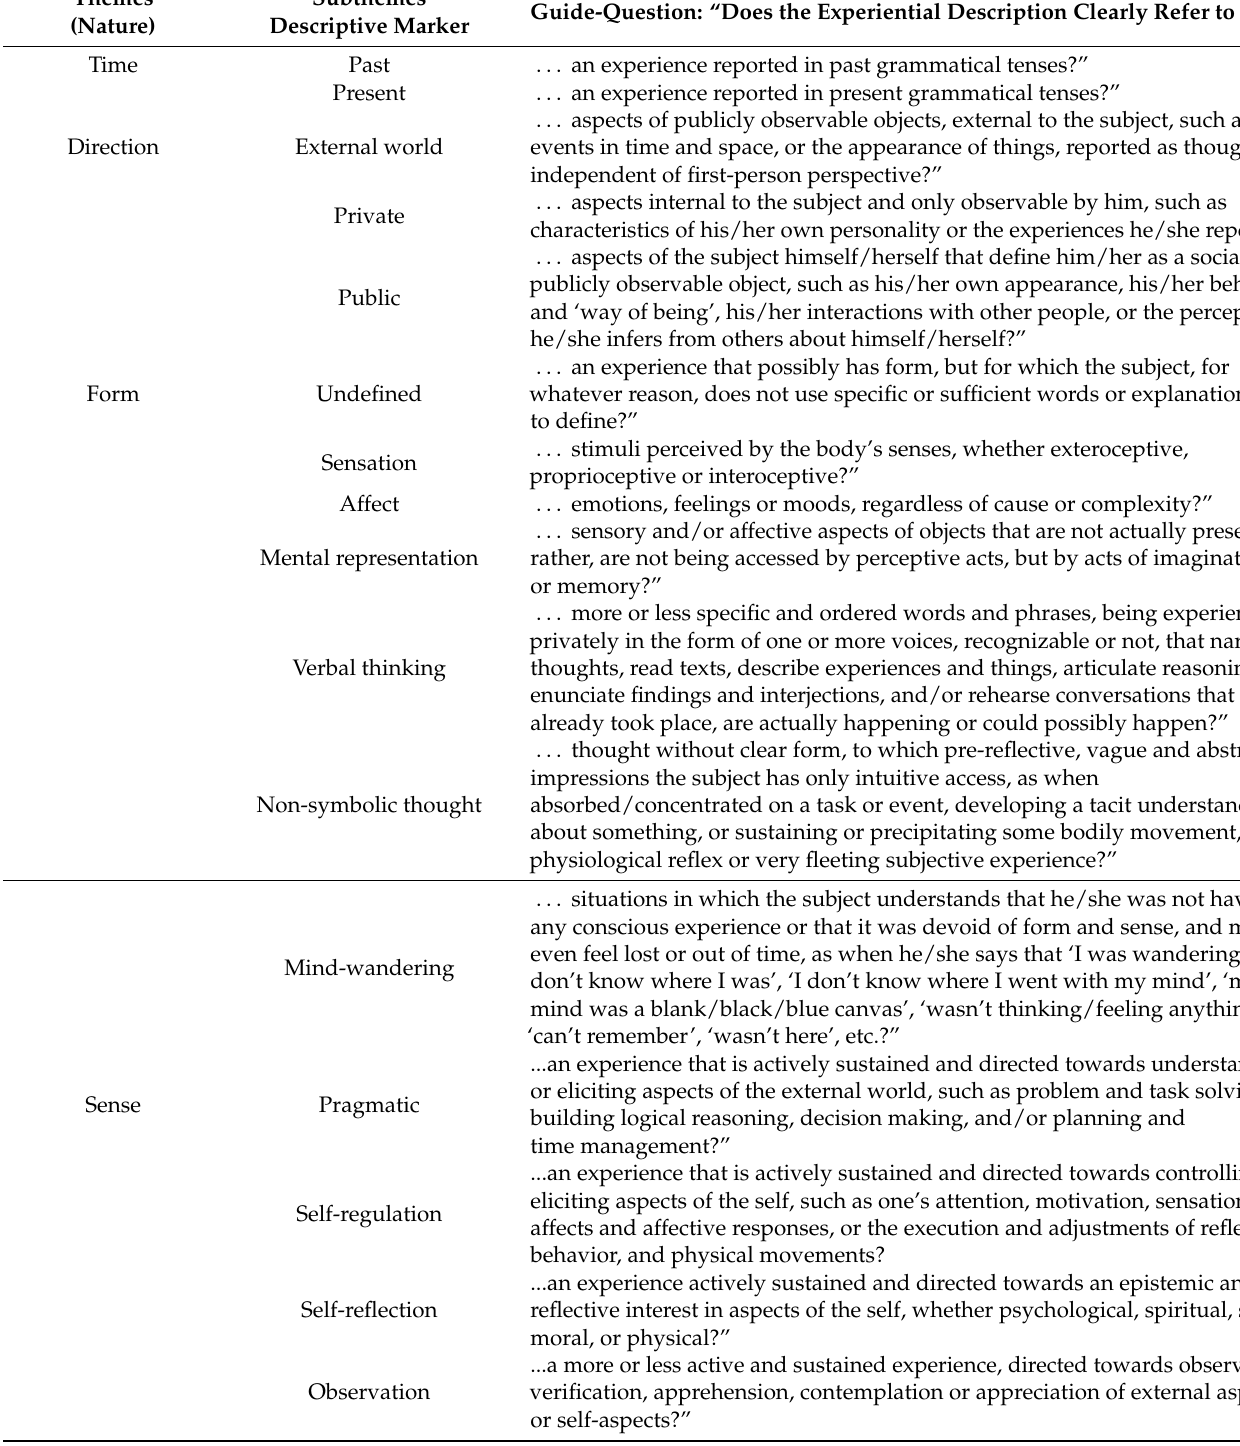
Table 1. Descriptive markers for qualitative analysis of self-descriptions of